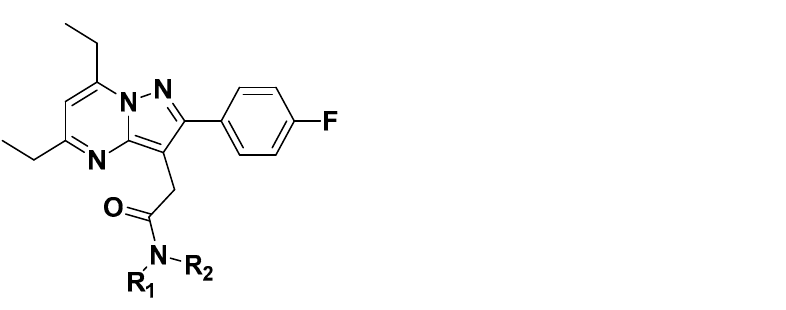
Figure 2. Chemical structure of novel pyrazolopyrimidine derivatives. Table 1. In vitro binding affinity and lipophilicity of new pyrazolopyrimidine derivatives.